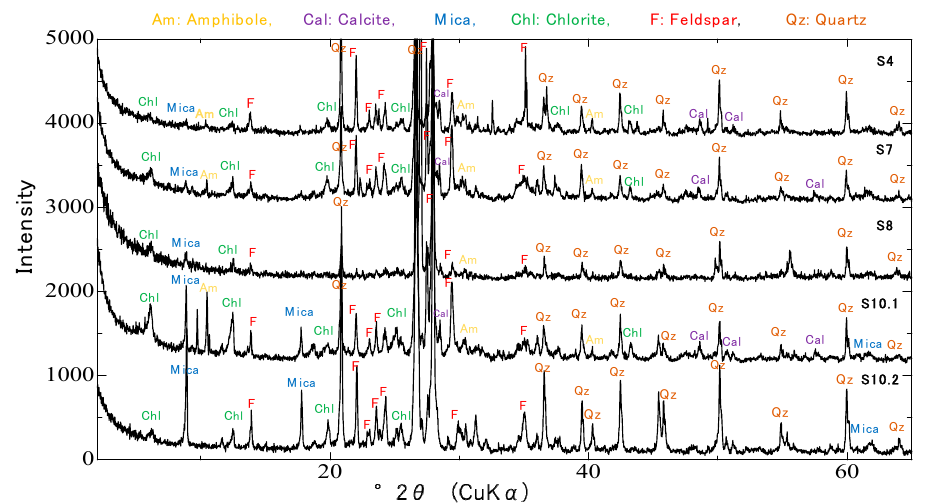
Figure A1. XRD patterns of the rivers (S4, Erdenet River; S7, Gavil River; and S8, Khangal River) and ponds (S10.1 and S10.2) sediment samples: Chl, chlorite; Mica, mica minerals; Am, amphibole; Cal, calcite; Qz, quartz; and F,